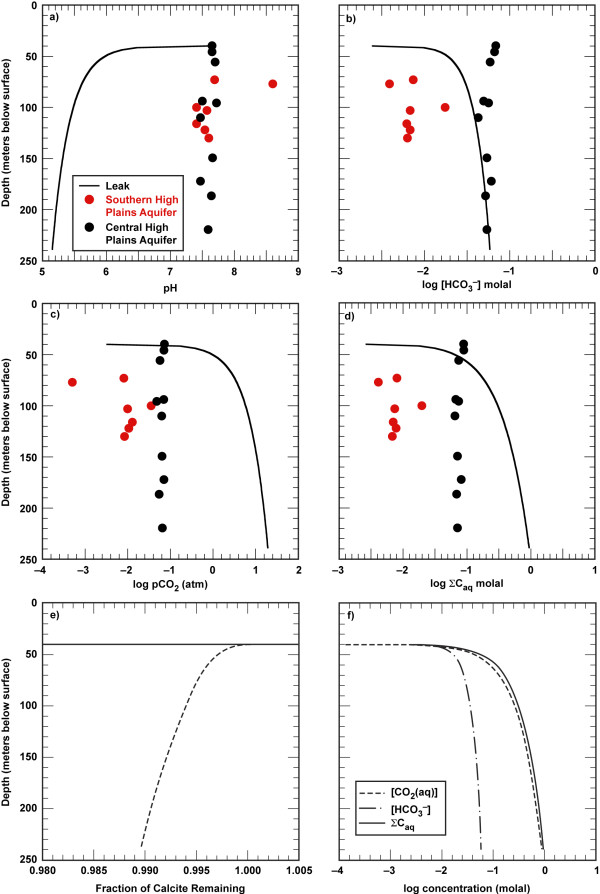
The geochemical response of carbon dioxide gas in a model sandstone aquifer is shown by difference between High Plains aquifer (symbols, [20,21]) and simulated groundwater chemistry (solid line) as depth versus pH (a), log [HCO3-] (b), log pCO2 (c), log ΣCaq (d), fraction calcite dissolved (e) and dissolved carbon speciation (f).